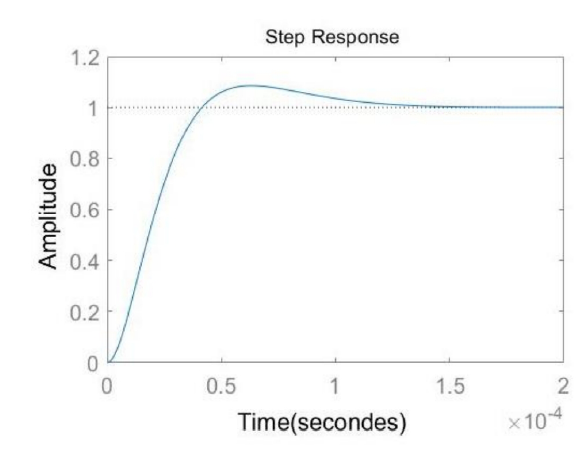
Fig. 7. Step response diagram of closed-loop transfer function.